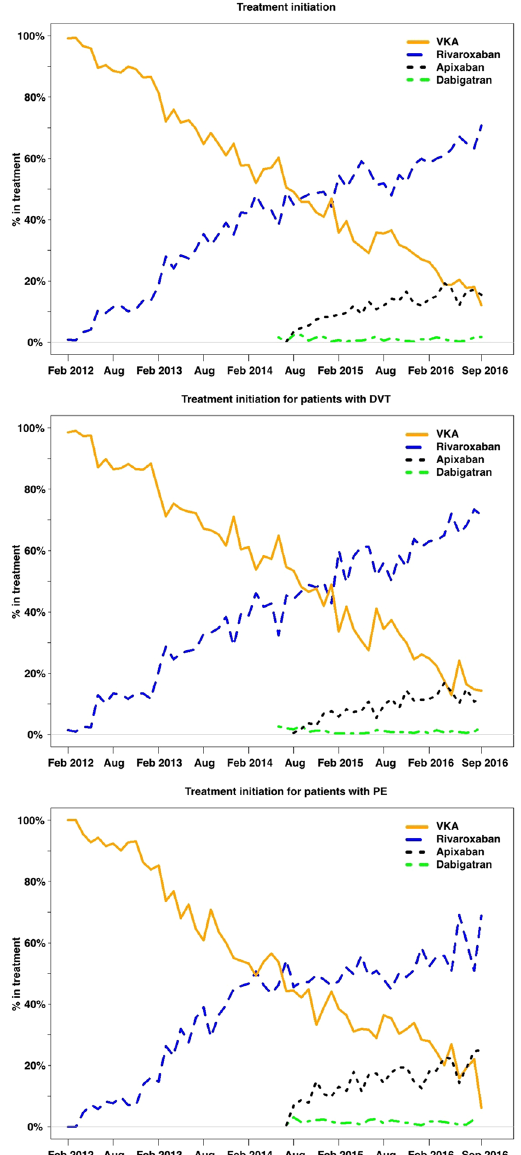
Figure 2. Temporal trends in initiation of anticoagulation therapy. Graph of temporal trend over initiation of oral anticoagulation therapy in patients with venous thromboembolism (VTE). Percentage of patients with VTE, pulmonary embolism (PE) or deep venous thromboembolism (DVT) initiating VKA, rivaroxaban, apixaban or dabigatran per month between February 2012 and September 2016. Rivaroxaban: p- value for increasing trend < 0.001, apixaban: p-value for increasing trend < 0.001, dabigatran: pValue for increasing trend < 0.991. VKA: p-value for decreasing trend <